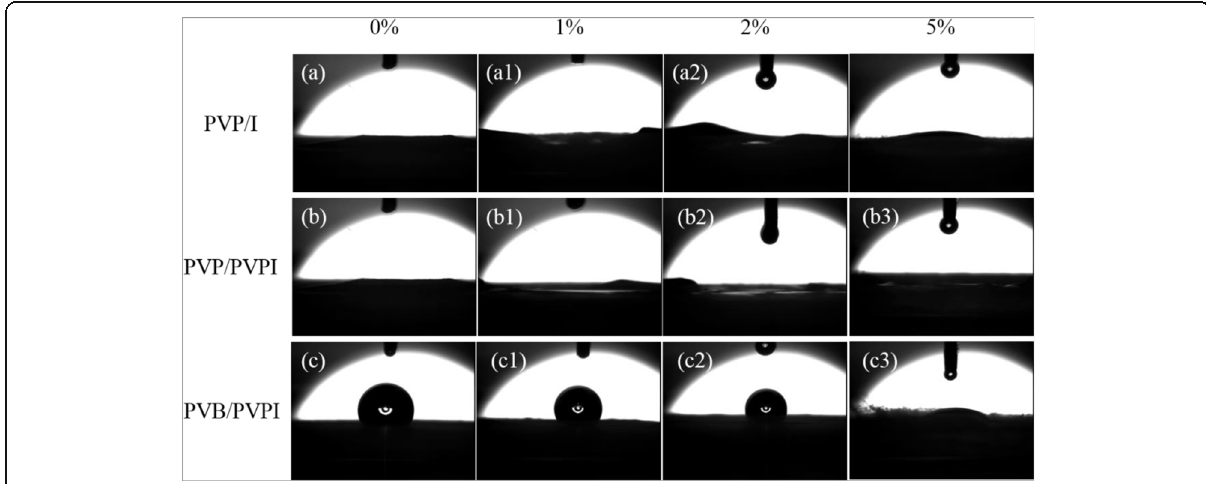
Fig. 5 SBF contact examination of the as-spun fibers PVP/I (a – a3), PVP/PVPI (b – b3), PVB/PVPI (c – c3) with different iodine/PVPI concentrations